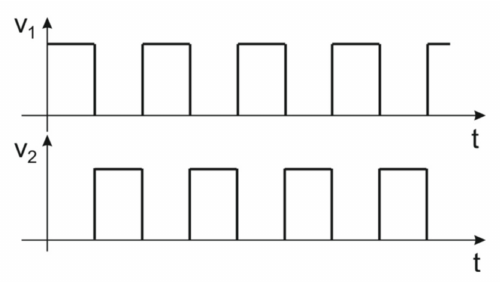
Figure 3. The waveforms of the voltages that supply the